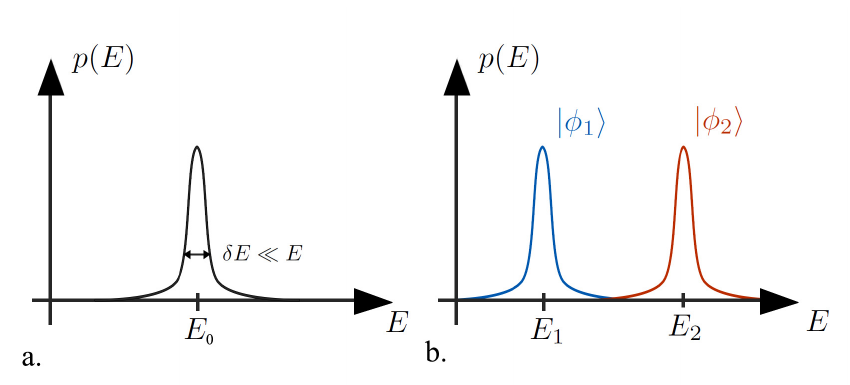
Figure 1: a. Traditional situation where the set of initial states all belong to a narrow energy window centered around E paper where we have a cat state made of a quantum superposition 1 /